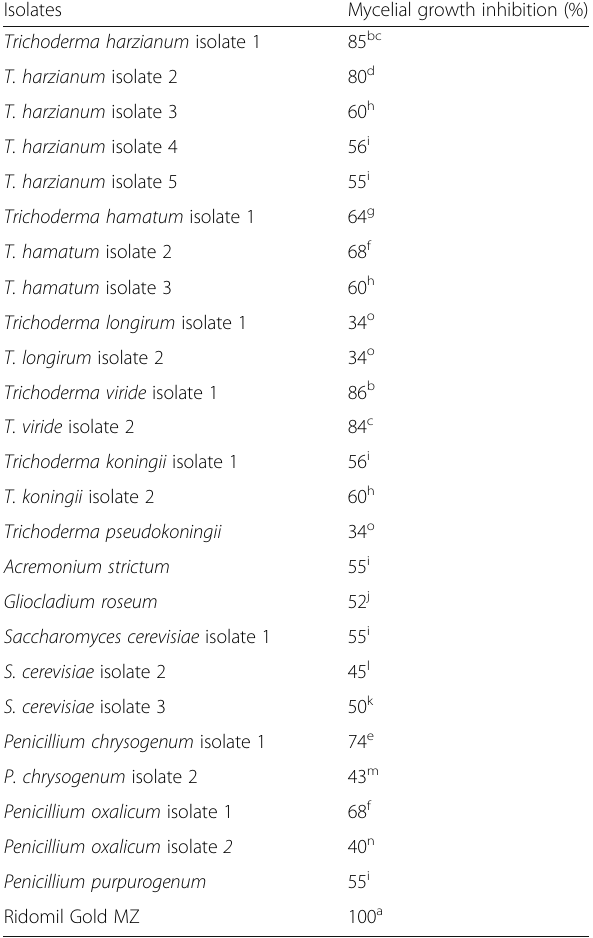
Table 1 Inhibitory effect of the tested bioagents and plant extracts against Botrytis allii in vitro